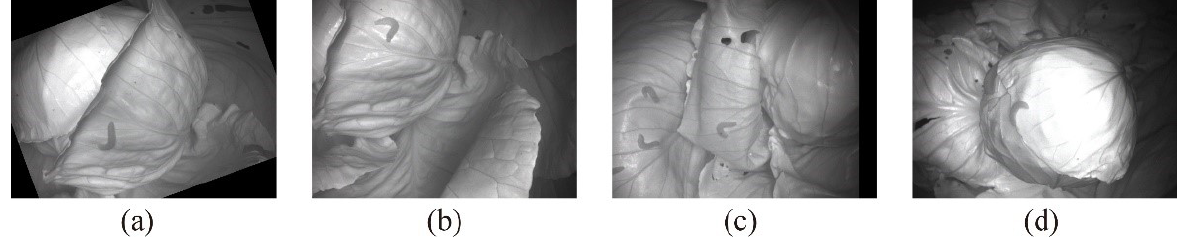
Figure 5. Data enhanced pest image. ( a ) Image rotation, ( b ) image flip, ( c ) image translation, and ( d ) change the brightness of the image.